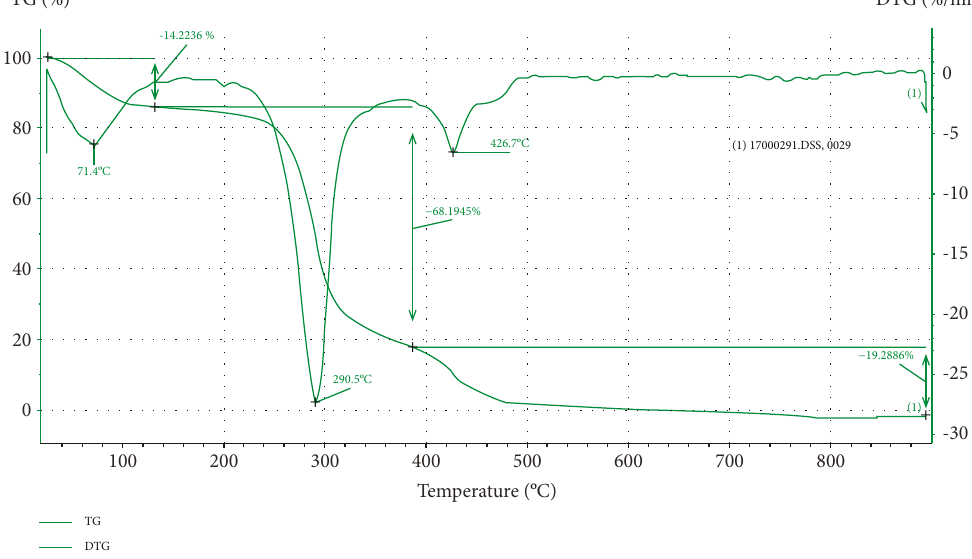
Figure 3: TG thermogravimetric curves for GAP in a dynamic atmosphere of nitrogen and oxygen.